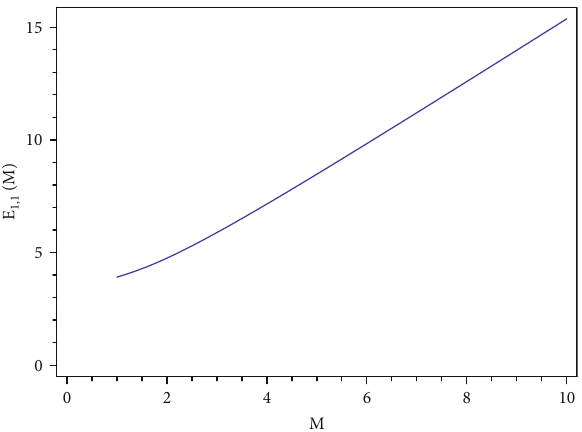
Figure 3: n = l = k = q = a = b = η